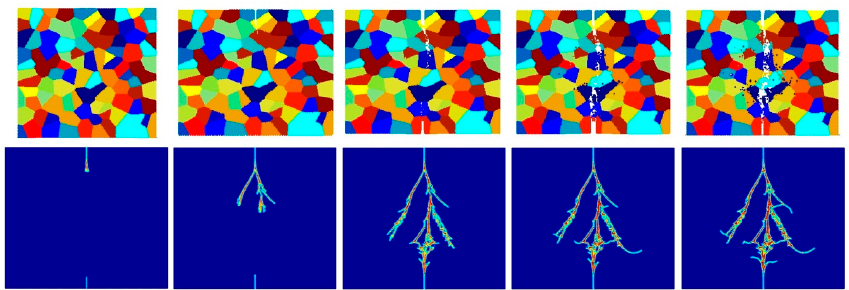
Figure 19. Fracture pattern of polycrystal when β = 1.0 with 300 × 300 particles. From left to right: time = 1.5 µ s, 2.0 µ s, 2.5 µ s, 3.0 µ s, and 3.5 µ s, respectively.